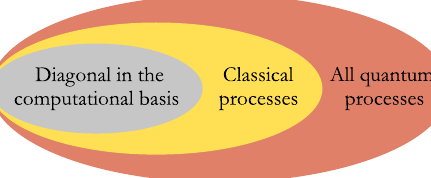
FIG. 7. Nested set of processes. Processes that cannot produce coherence and destroy any coherence that is fed in (i.e., their Choi states are diagonal in the computational basis) form a strict subset of processes that appear classical when sequentially probed in the computational basis. Both of these sets, as well as the set of all quantum processes, are